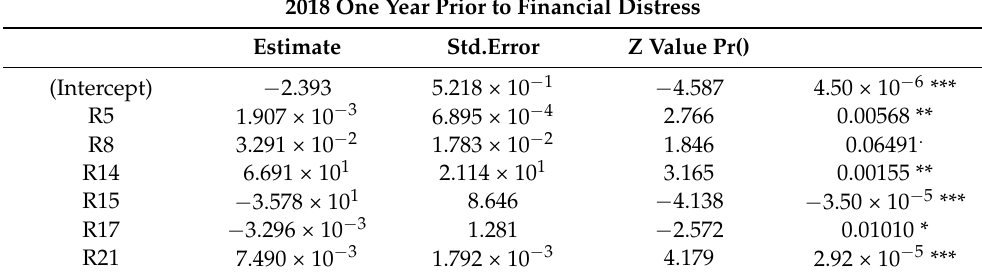
Table 5. Stepwise logistic regression results in